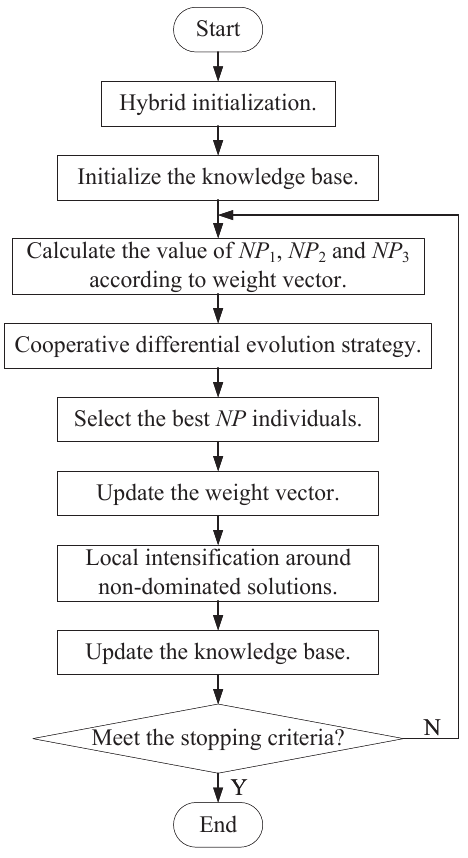
Figure 3. Framework of KCDE for